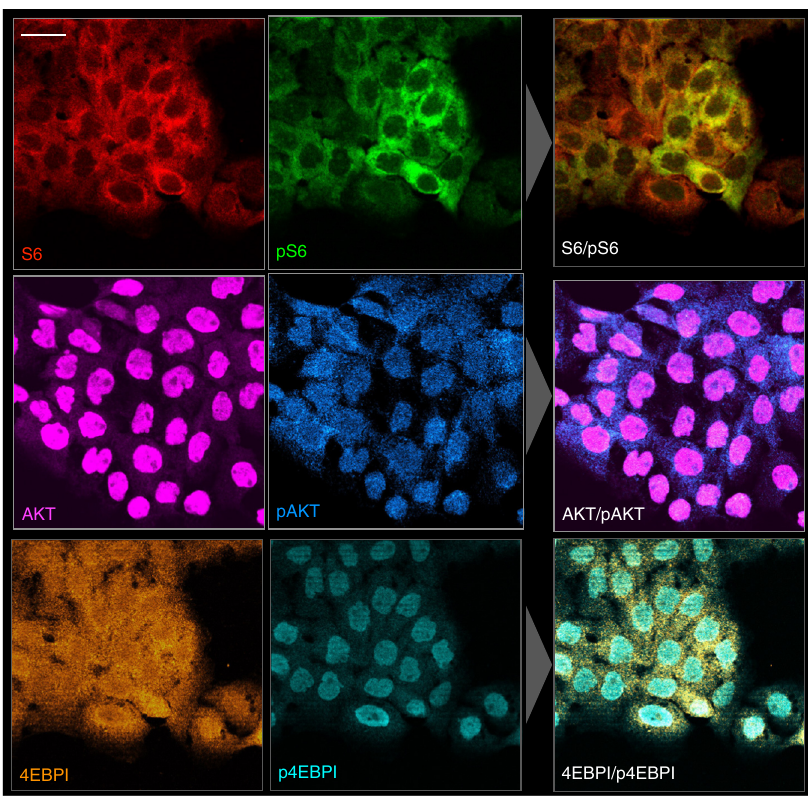
Fig. 4 Phosphoprotein analysis in single cells. Representative examples of phosphoprotein ratio imaging for S6/pS6RP (calculated corrected ratio of pS6/ S6 of 0.41), AKT/pAKT (calculated ratio of pAKT/AKT of 0.16), and 4EBP1/p4EBP1 (calculated ratio of p4EBP1/4EBPI of 0.3) in cultured A431 cells. Scale bar (top left) represents 50 µ